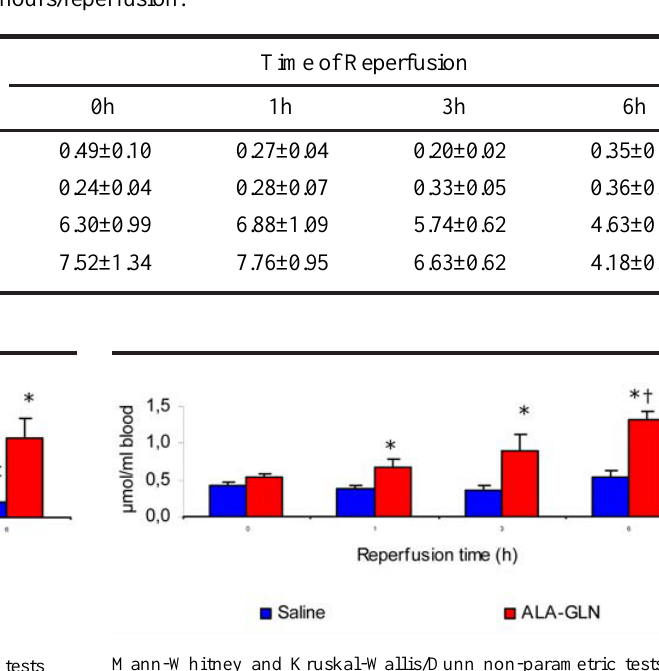
FIGURE 3 - Blood ketone bodies concentrations in saline and L-alanyl-glutamine treated rats.